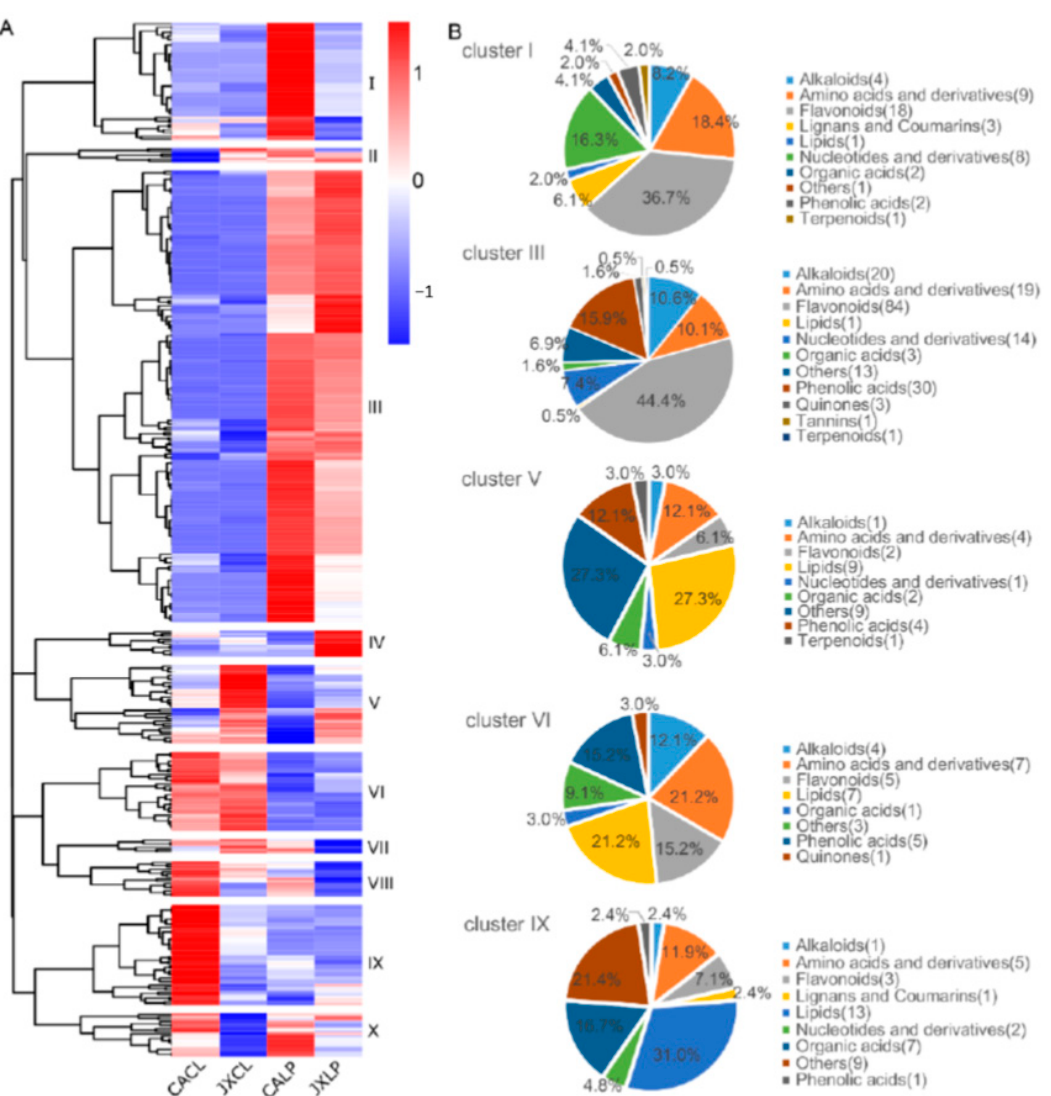
Figure 2. The clustering profiling of the identified metabolites. ( A ) Heatmap indicating the clusters of different metabolites. The red color represents higher content, and the blue color represents the lower content. ( B ) Classification of the metabolites in different clusters in the heatmap. “CA”, China Antique; “JX”, JianXuan-17; CL, cotyledon; LP; lotus